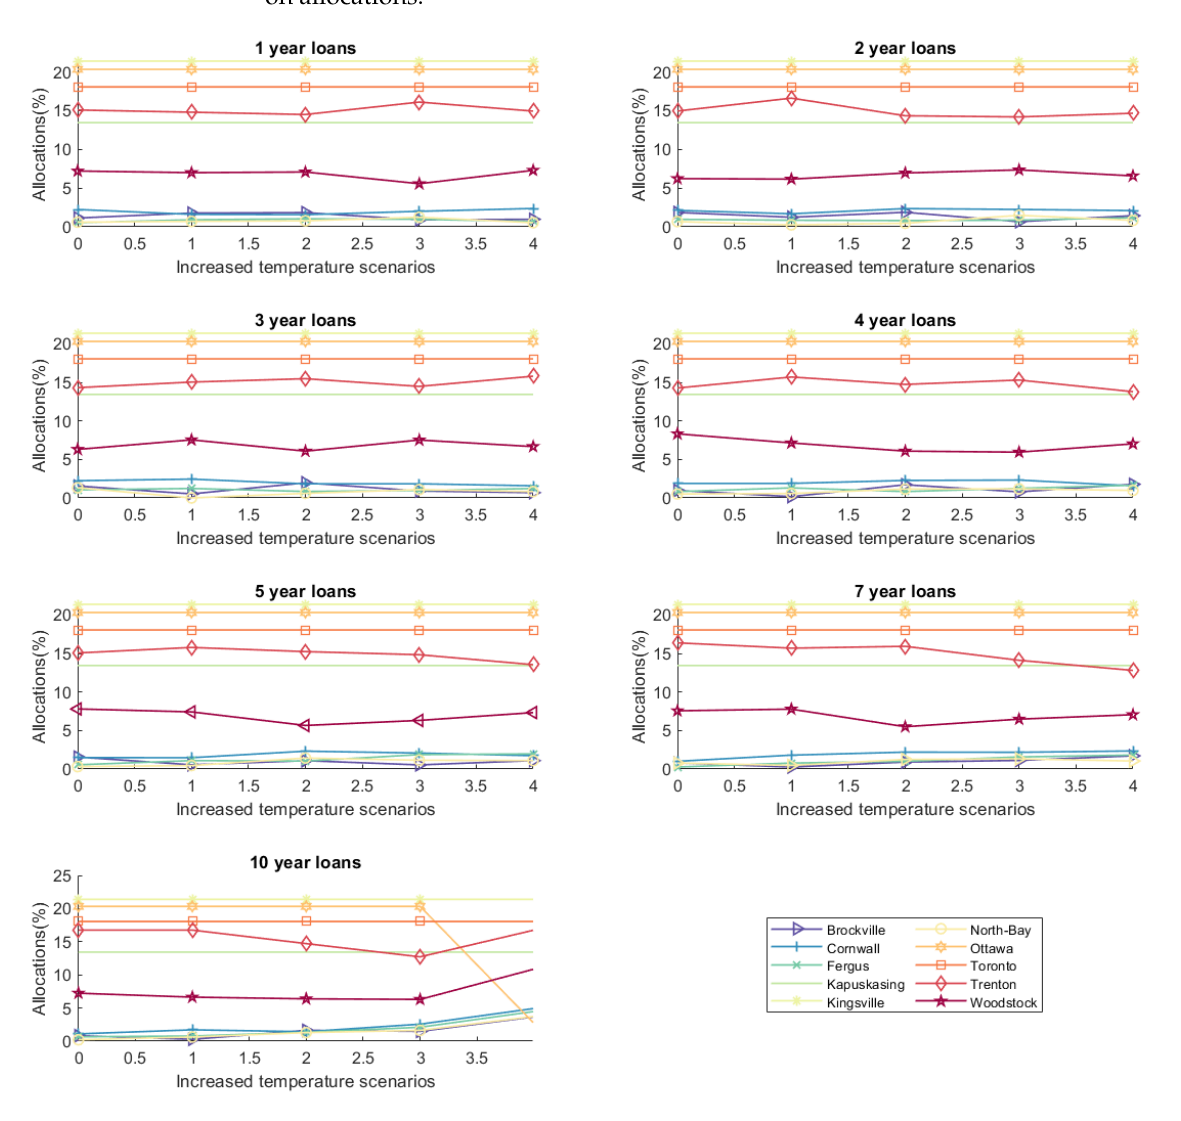
Figure 11. Allocations to each region when the entire budget is invested in one type of loan under five different 1 ◦ C increased temperature